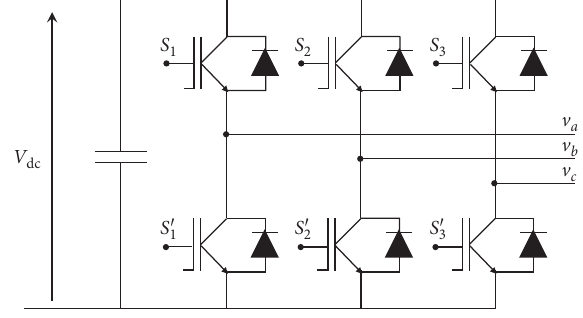
Figure 1: Voltage source inverter structure.